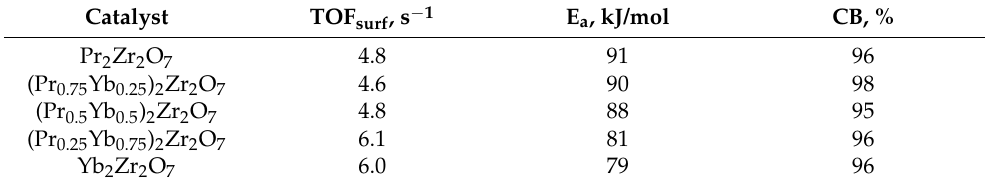
Table 2. Catalytic characteristics of complex oxide systems in the process of propane